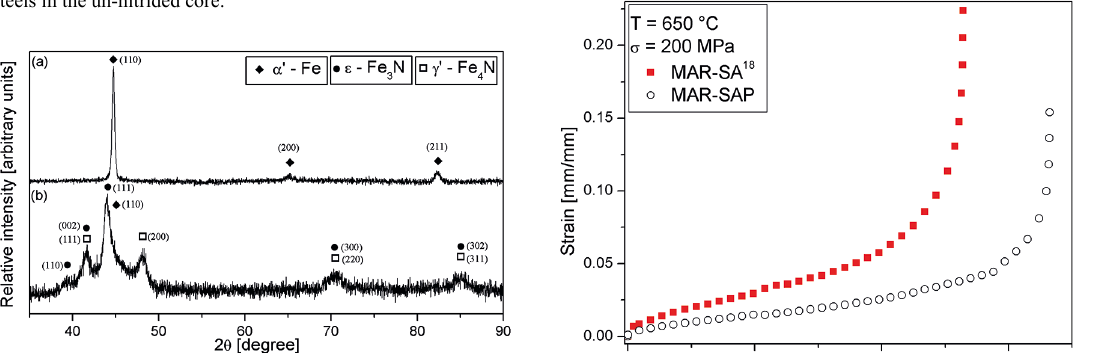
Figure 1: Optical micrograph of the MAR-SAP showing the nitrided layer and typical plate-like martensite microstructure of maraging steels in the un-nitrided core.